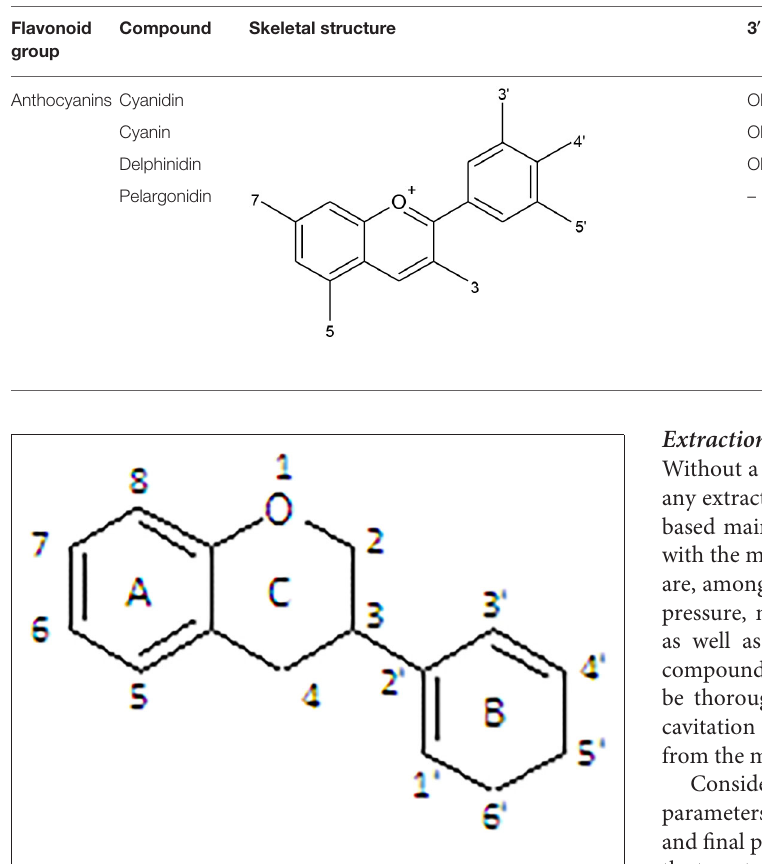
FIGURE 2 | Chemical structure of